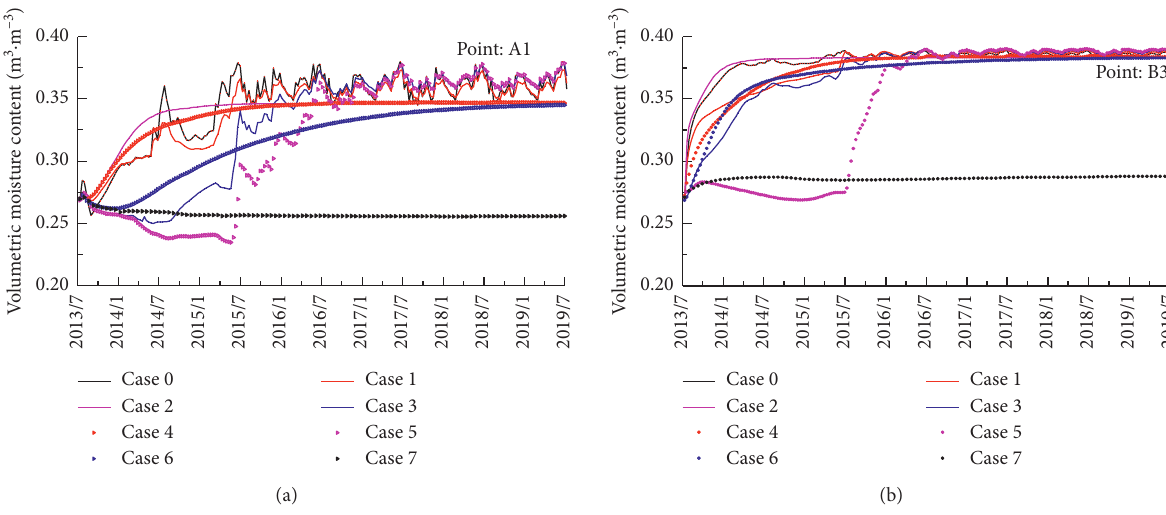
Figure 12: Comparison of the volumetric moisture content for the different combination: (a) point A1 and (b) point